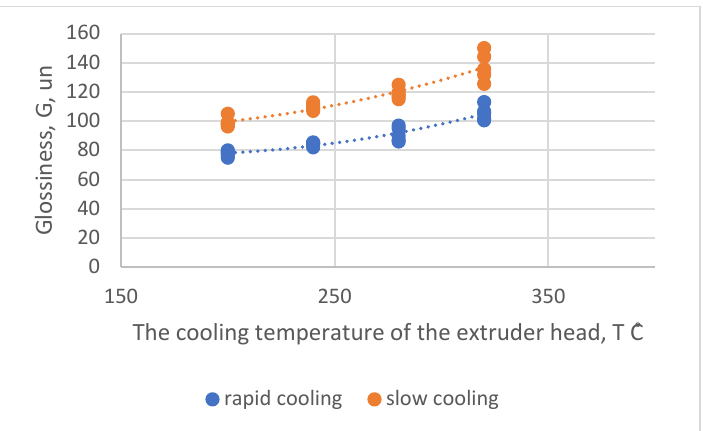
Figure 14. Dependence of glossiness (G) on the cooling temperature of the extruder head.